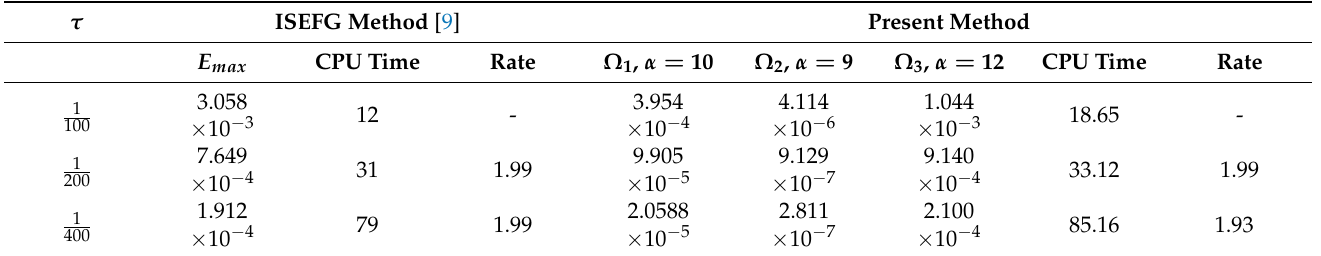
Table 3. E max and the effect of the time steps and domain at times T = 1 for Example 3, where c = 5,